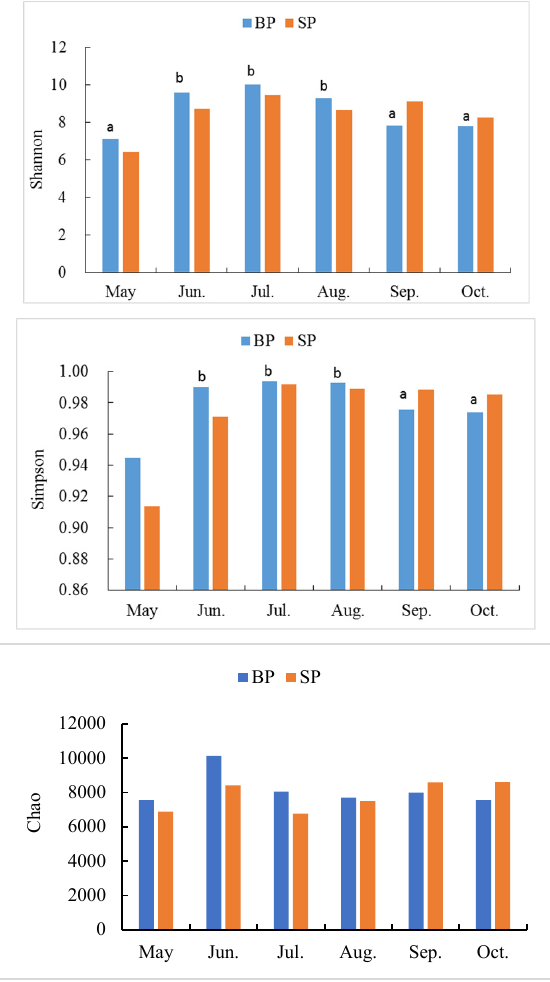
Figure 1. Microbial diversity and richness in ponds with large (BP) and small (SP) area during a culture cycle. Letters a and b indicate significant differences ( p < 0.05) among sampling months.